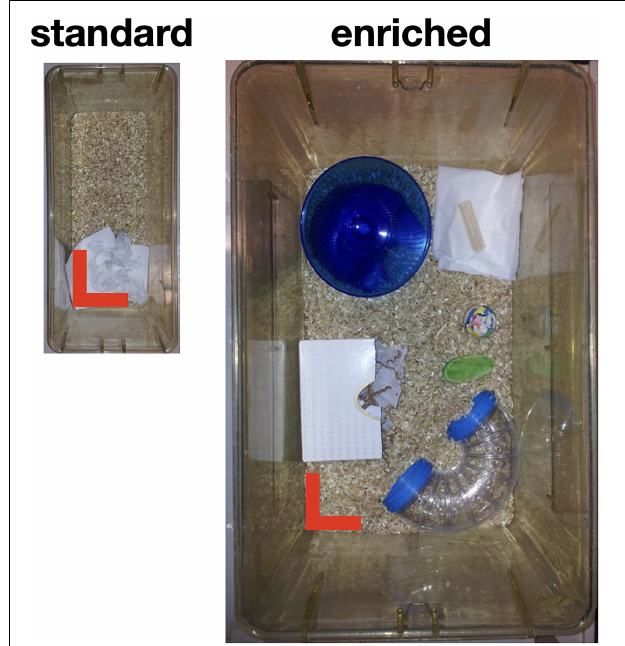
FIGURE 1 | Housing of animals. Standard housing cages, being 33 × 15 cm 2 in size (13 cm height), compared to our Enriched housing cages of 48 × 38 cm 2 in size (21 cm height). Note that the pictures are roughly in the same scale. The red bars indicate 10 cm.